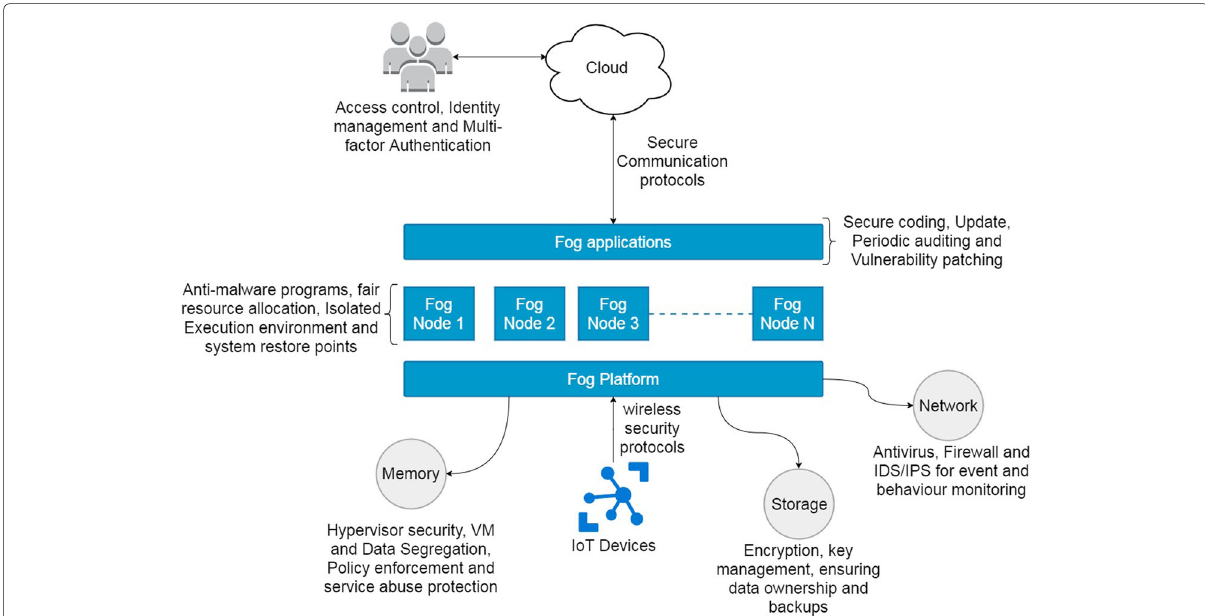
Fig. 4 Fog Computing Platform and the deployment of security solutions on various components of the Fog system. This figure shows how and where proposed security solutions can be placed and help in eliminating various security